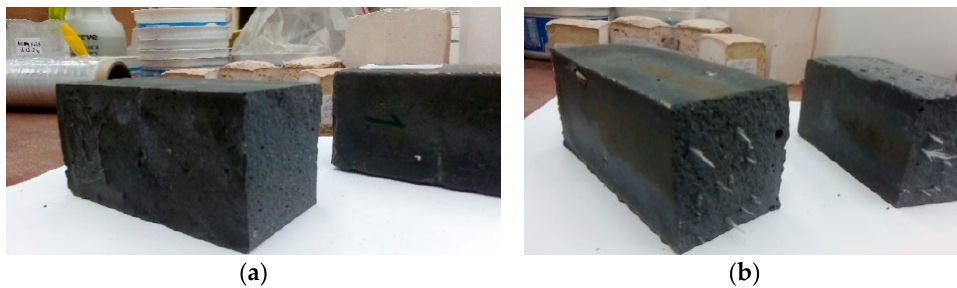
Figure 9. Breakthrough of samples based on fly ash ( a ) without reinforcement; ( b ) with 0.5% addition of glass fiber.